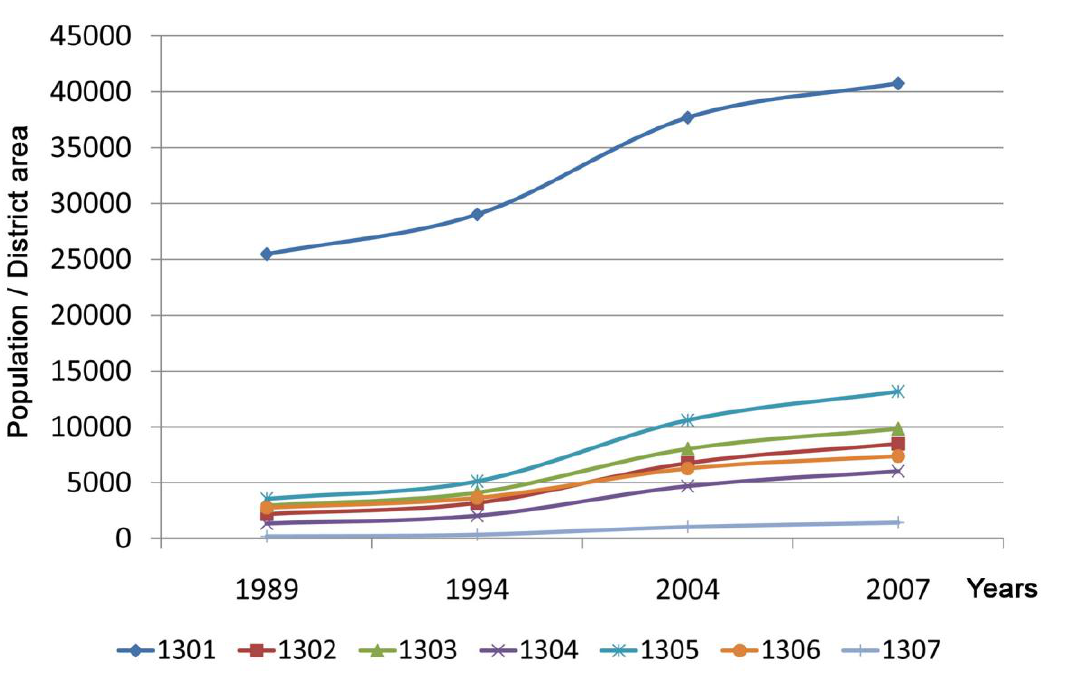
Figure 11. Comparison of population densities and density change during the observed period per district. Each curve represents a district. The ordinate shows the observed period from 1989 to 2007. The abscissa indicates the number of people per district area [km 2